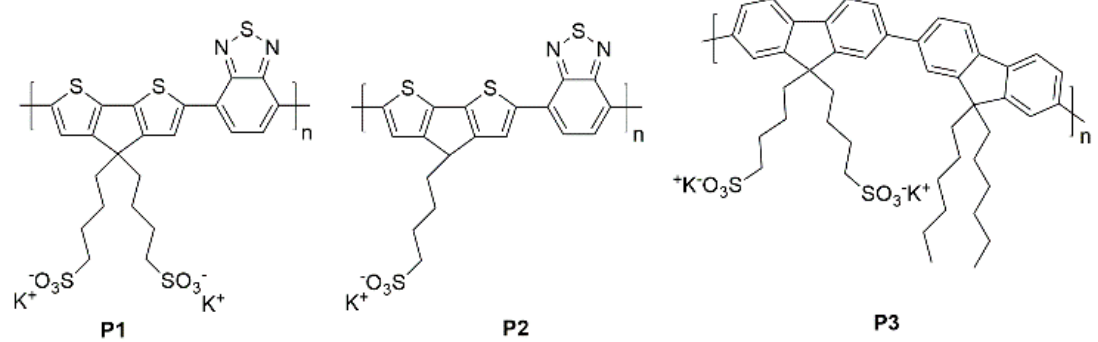
Figure 1. Chemical structure of the synthesized CPEs.